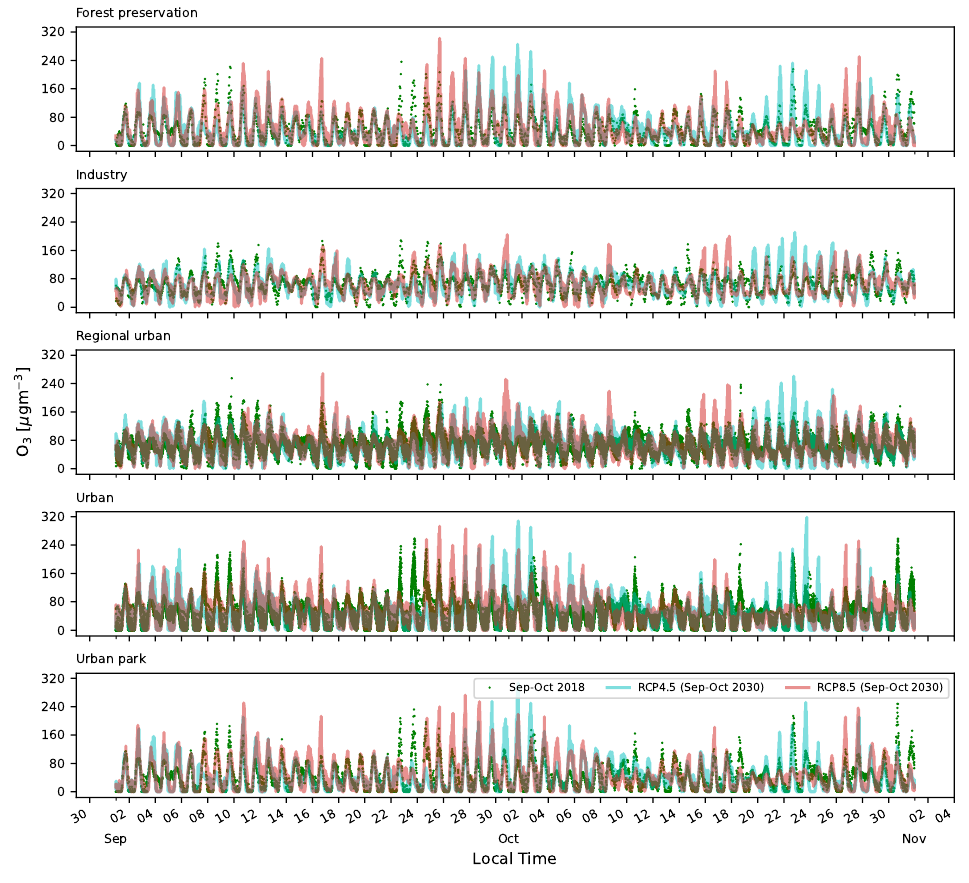
Figure 6. Comparison of modeled surface ozone concentrations for September–October 2018 (base case scenario) and September–October 2030 under RCP 4.5 and RCP 8.5 scenarios. The analysis considered model simulations at 56